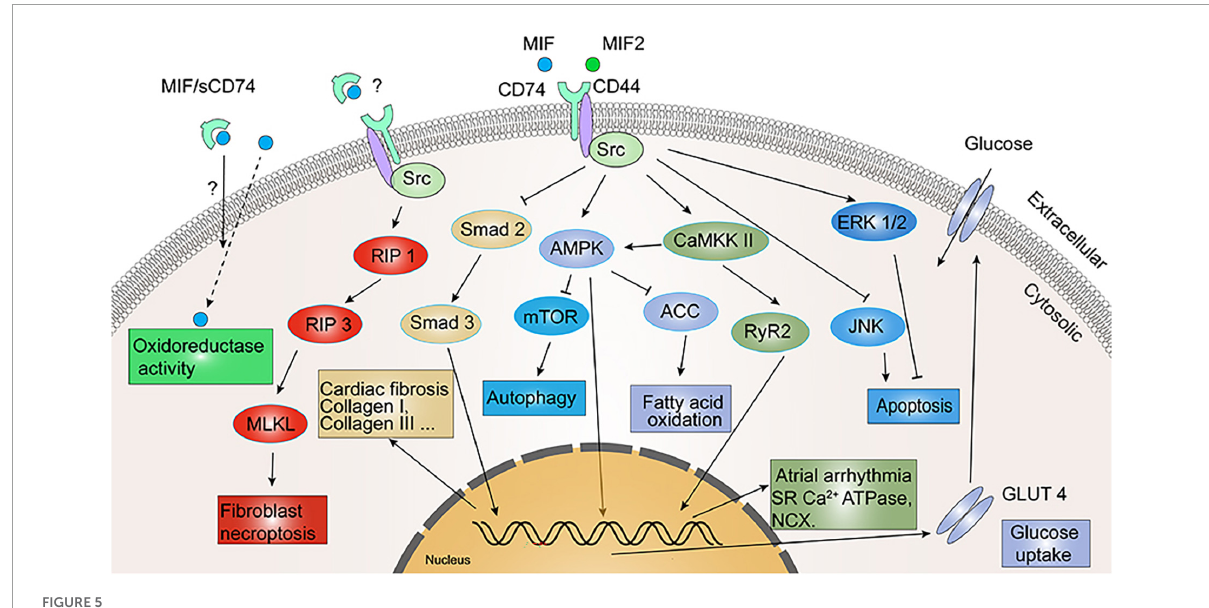
FIGURE5 Signaling cascades in cardiovascular diseases involving migration inhibitory factor/leukocyte differentiation antigen 74 (MIF/CD74) and MIF2/CD74. MIF exerts myocardial protection by inhibiting c-Jun N-terminal kinase (JNK) and activating extracellular signal-regulated kinase (ERK) 1/2-mediated cardiomyocyte apoptosis. MIF/CD74 and MIF2/CD74 reinforce glucose uptake and utilization by activating adenosine monophosphate-activated protein kinase (AMPK) to promote GLUT4 expression, and inhibit fatty acid oxidation by inhibiting ACC. MIF/CD74 promotes sarcoplasmic reticulum (SR) Ca 2 + ATPase and Na + /Ca 2 + exchanger (NCX) expression and activation via CaMKK II/RyR2 to regulate atrial arrhythmia. MIF/CD74 inhibits myocardial fibrosis through inhibition of Smad 2/Smad 3 and promotes fibroblast necroptosis through regulated intramembrane proteolysis 1 (RIP 1)/RIP 3/MLKL. Oxidoreductase activity of MIF also attenuates myocardial hypertrophy and I/R injury oxidative stress, while sCD74 appears to enhance this